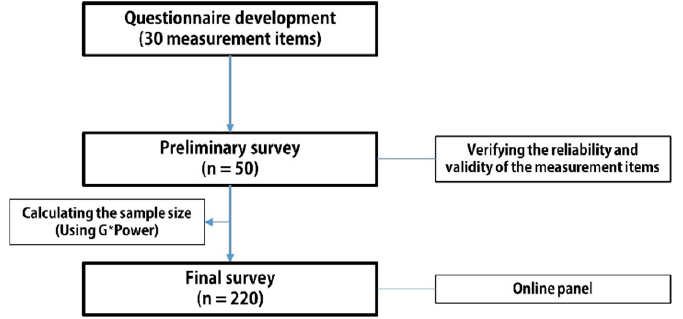
Figure 2. Data-collection procedure.